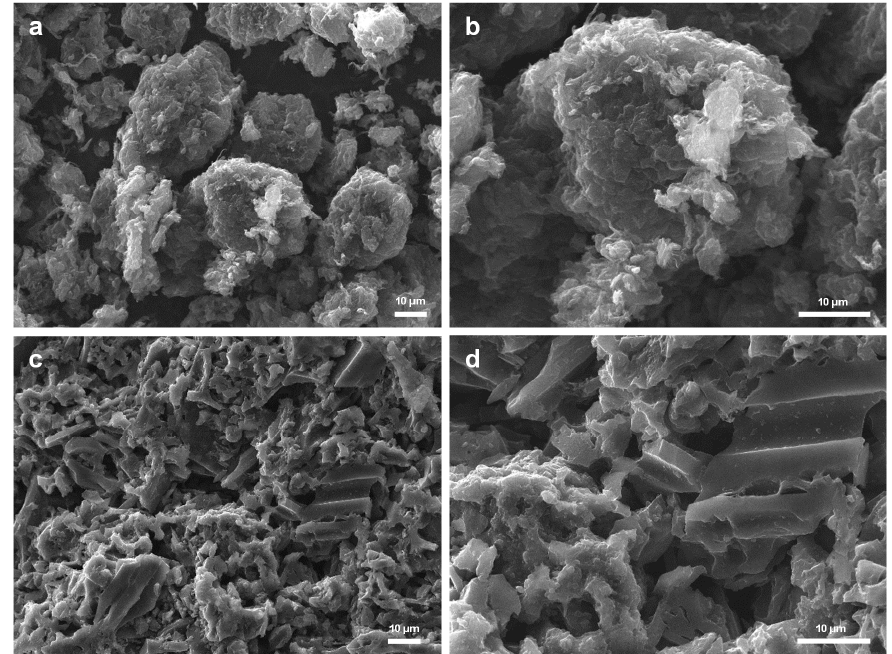
Figure 4. SEM images of the heterogenized samples: ( a , b ) 1 @CNT-ox; ( c , d ) 2 @AC-ox.